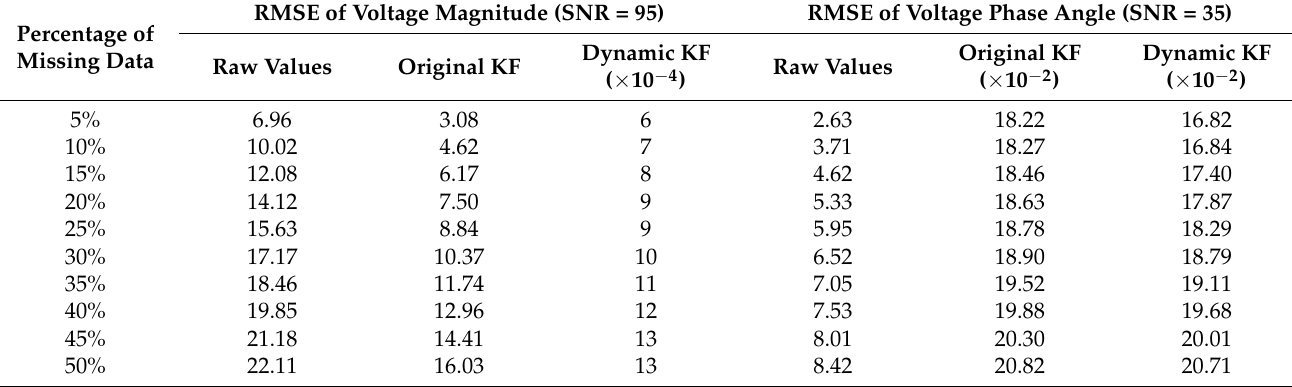
Table 3. Performance comparison of missing data recovery between the dynamic and original Kalman filters at bus 60 ( T max = 1500).